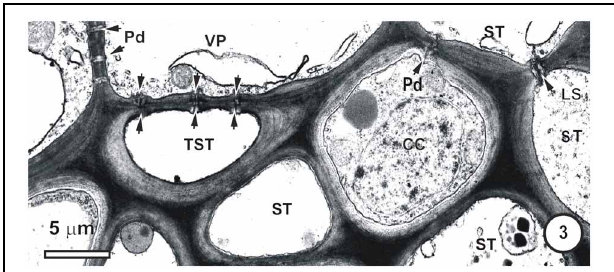
FIGURE 5 | Aspects of anatomy and cell associations in a small transverse vein in the leaf blade of Saccharum officinarum (NCO 376). This vein contains one metaxylem vessel (MX) coupled via prominent half-bordered pit pairs (arrowheads) to xylem vascular parenchyma cells (XVP), which, in turn, are symplasmically associated with several vascular parenchyma cells (VP). A solitary sieve tube is next to the MX. Judging by the thin wall it is in all probability an ST.